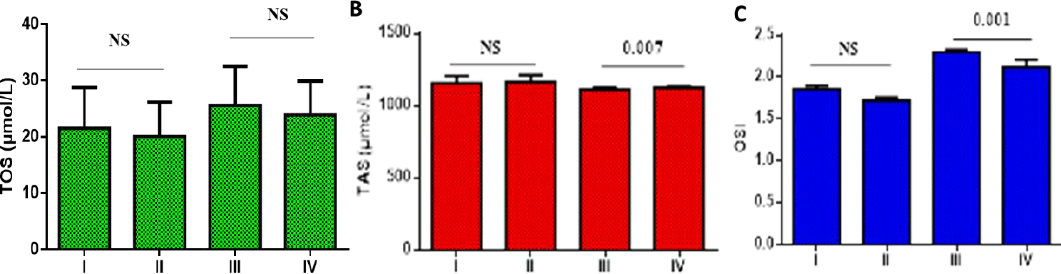
Figure 3. Effects of metformin plus sitagliptin treatment on the oxidative stress in T2DM patients with COVID-19: I: T2DM patients on metformin plus sitagliptin, II: T2DM patients with mild-moderate COVID-19 on metformin plus sitagliptin, III: T2DM patients with severe COVID-19 on metformin plus sitagliptin. ( A ): TOS: total oxidant status; ( B ): TAS: total antioxidant status; ( C ): OSI: oxidative stress index.